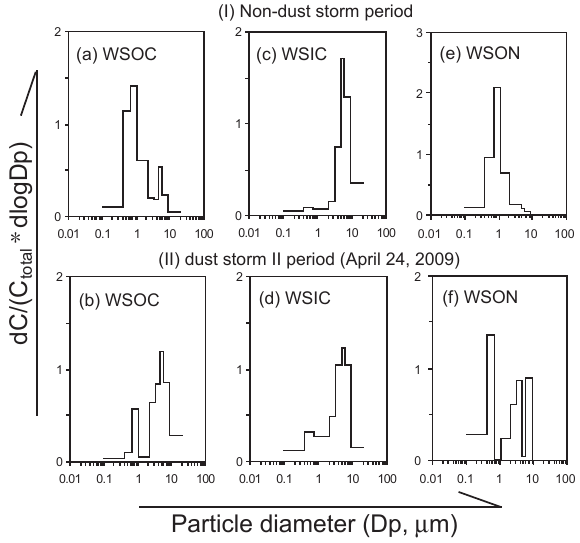
Fig. 9. Size distribution of water-soluble organic carbon (WSOC), inorganic carbon (WSIC) and organic nitrogen (WSON) in Xi’an during ( I ) the non-dust storm and ( II ) the dust storm II periods.